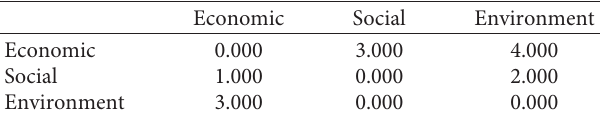
Table 25: Total relationship matrix of sustainability dimensions in deterministic